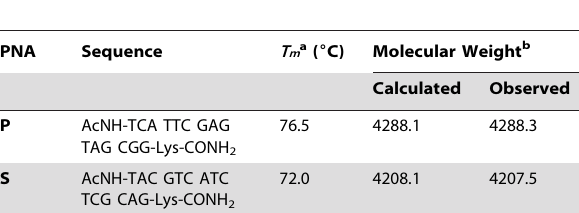
Table 1. PNA Sequences, Melting Temperatures, and Mass Spectroscopy Characterization.